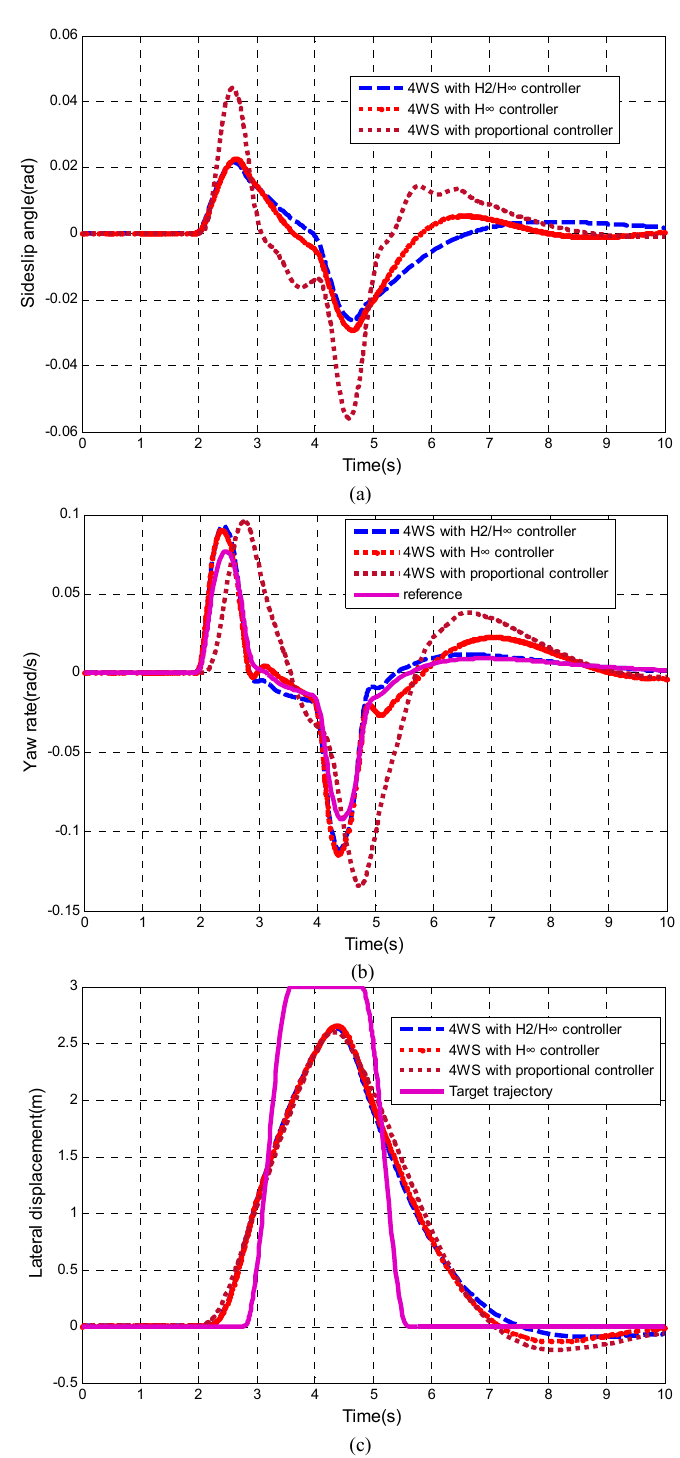
Figure 26. The double-lane change maneuver simulation results: ( a ) sideslip angle response; ( b ) yaw rate response; ( c ) lateral displacement response.